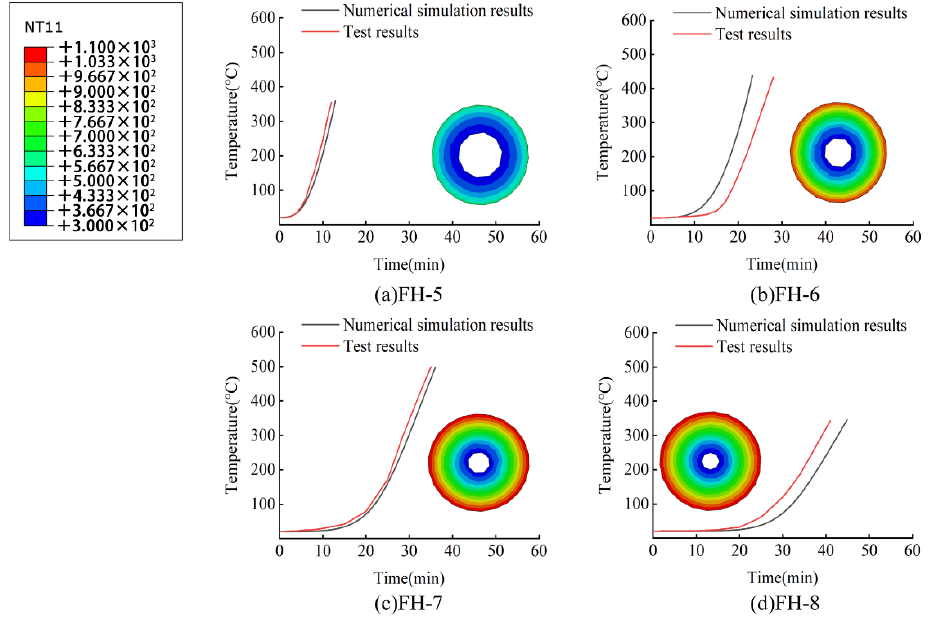
Figure 16. Comparison between finite element simulation and test results of fire resistance of ceramic fiber felt. Table 7. Errors between test and simulation results of fire resistance times of ceramic fiber felt.